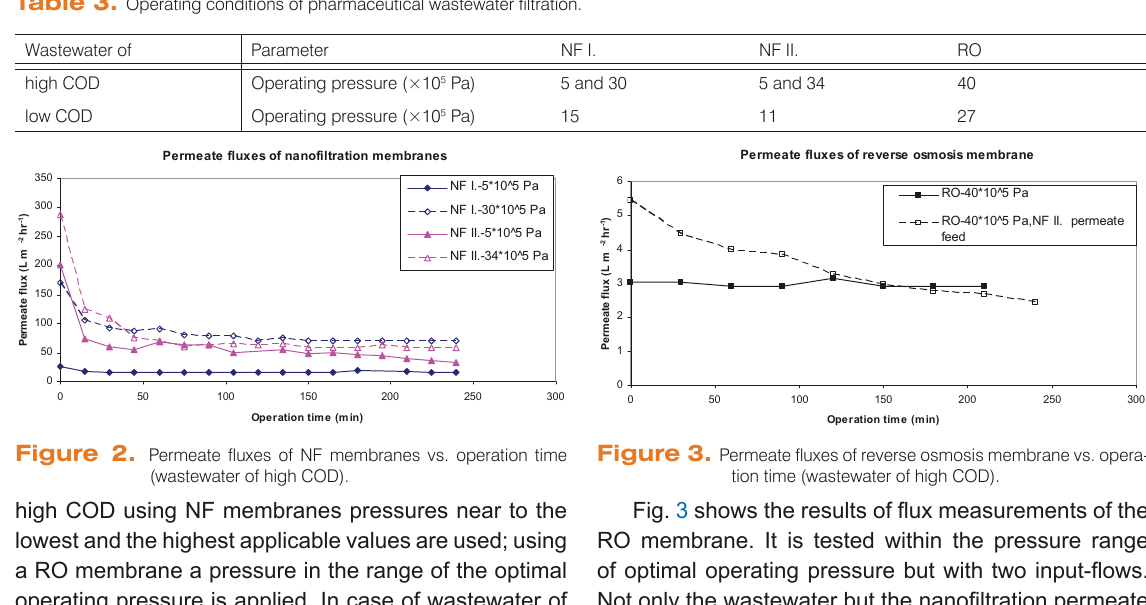
Table 3. Operating conditions of pharmaceutical wastewater filtration.